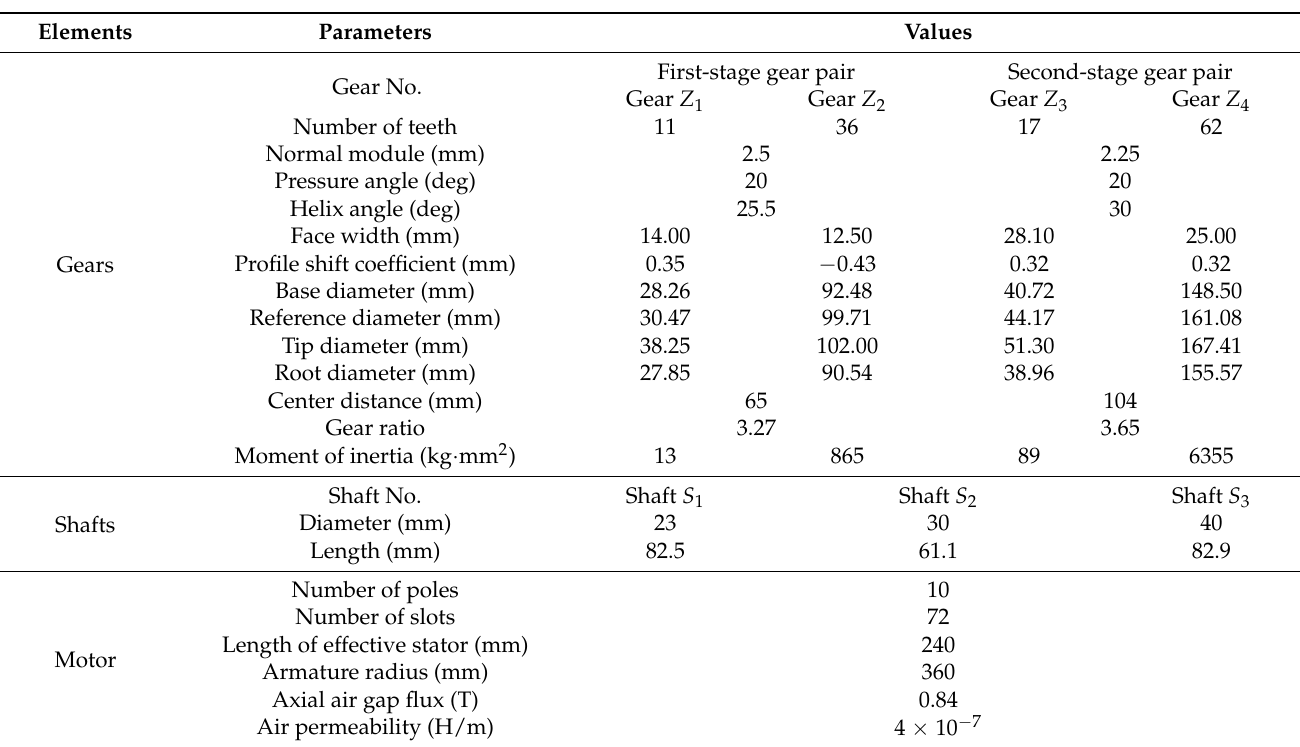
Table 1. Parameters of elements.